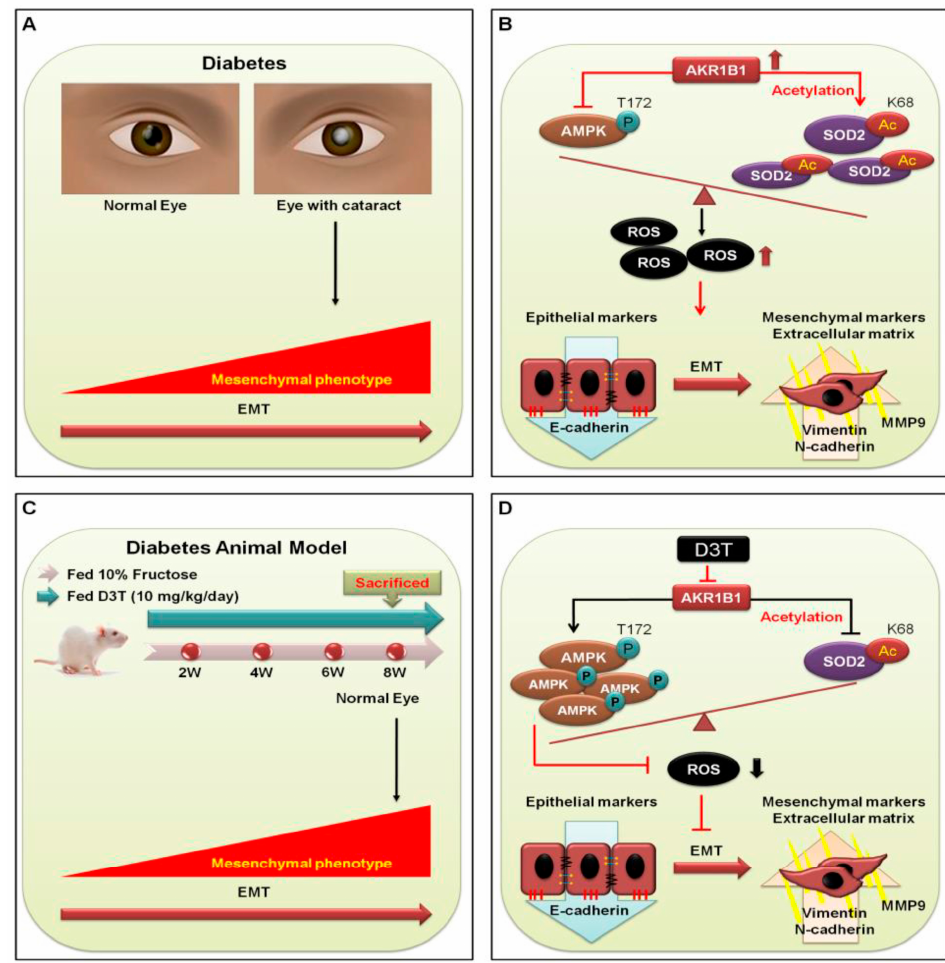
Figure 5. A summary of EMT function and D3T − downregulated AKR1B1 signaling pathway. ( A ) Diagram depicting the signal transduction pathways in DM (+) and DM ( − ) cataract patients. ( B ), In DM ( − ) cataract patients, p-AMPK T172 normal function is to regulate SOD2 activity to remove unwanted ROS. However, in DM (+) cataract patients, AKR1B1 inhibits the expression of p-AMPK T172 and promotes SOD2 acetylation to form AcSOD2 which leads to failure of ROS removal. The accumulated ROS induces oxidative stress, which in turn induces EMT progression, leading to the downregulation of epithelial marker and upregulation of mesenchymal markers (red line). In addition, N-cadherin and MMP9 expressions are significantly higher in DM (+) cataract patients. ( C ) WKY rats fed 10% fructose in drinking water for 8 weeks; or WKY rats fed 10% fructose in drinking water and administered D3T (10 mg/kg/day) via gavage for 8 weeks. ( D ) Fructose re- quires AKR1B1 to increase ROS generation (black line), and ROS accumulation further inhibits the expression of p- AMPK T172 and promotes SOD2 acetylation to form AcSOD2. In consequence, accumulated ROS stress induces EMT pro- gression (red line). In contrary, D3T is capable of inhibiting the effect of fructose-activated AKR1B1 signaling cascade. Abbreviations AKR1B1, Aldo-keto reductase family 1, member B1; AcSOD, acetylated superoxide dismutase; AMPK, AMP-activated protein kinase; AGEs, advanced glycation end products; DM, diabetes melli- tus; DHE, dihydroethidium ; DR, diabetic retinopathy; D3T, 3H-1,2-dithiole-3-thione; EMT, epithe- lial-mesenchymal transition; GLUT, glucose transporter; LECs, lens epithelial cells; NADPH, nico- tinamide adenine dinucleotide phosphate; RAGE, receptor for advanced glycation end products; ROS, reactive oxygen species; SOD, Superoxide dismutase.